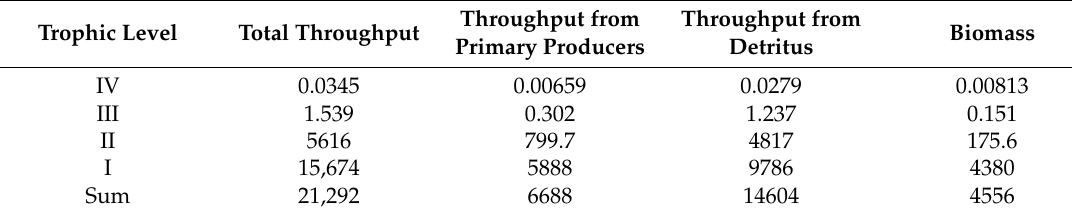
Table 3. Flows and biomasses of the Lake Datong ecosystem (t / km 2 ).